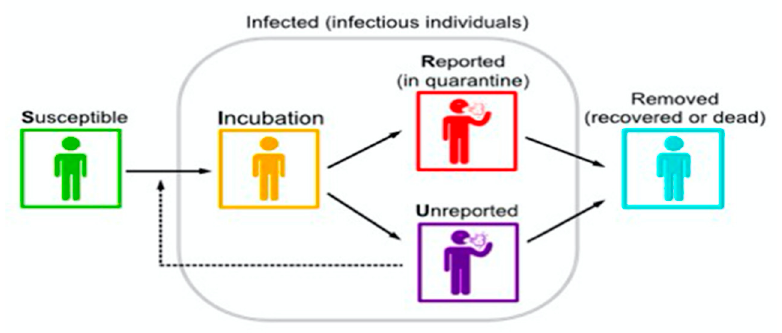
Figure 2. Flow chart of SIR model adding a new sub-compartment related to unreported cases.